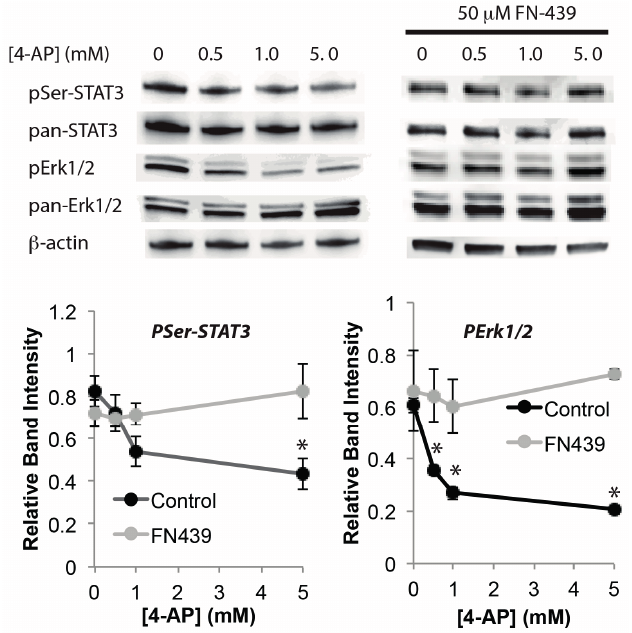
Figure 1. Inhibition of matrix-metalloproteinases (MMPs) blocks the decline of levels of survival signaling induced by chronic network activation. Western blot analysis of total STAT3 (pan-STAT3), pSer-STAT3, total Erk1/2 (pan-Erk1/2) and pErk1/2. β -Actin was used as control ( n = 4, * p < 0.05, one-way ANOVA). Neurons were treated with the indicated concentrations of 4-AP for 18 h with or without 50 μ M